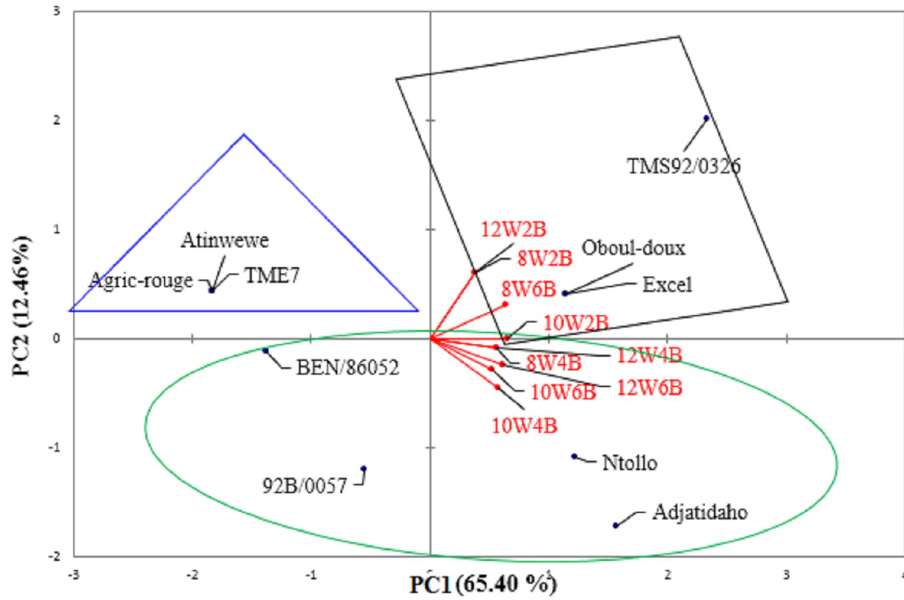
Fig 5. PCA biplot of disease severity in cassava cultivars along principal components PC1 and